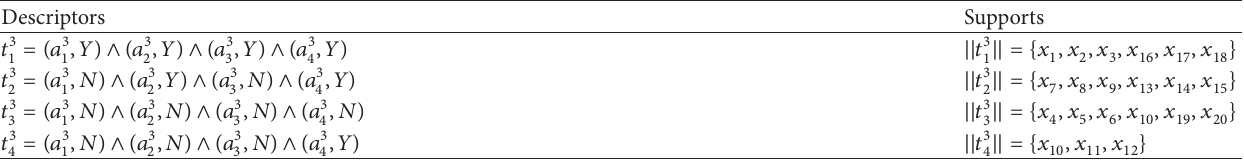
Table 4: Full AT 3 descriptors and their